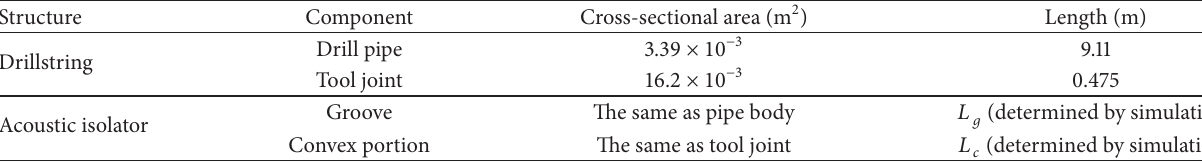
Table 1: Dimensions of drillstring and single acoustic isolator.